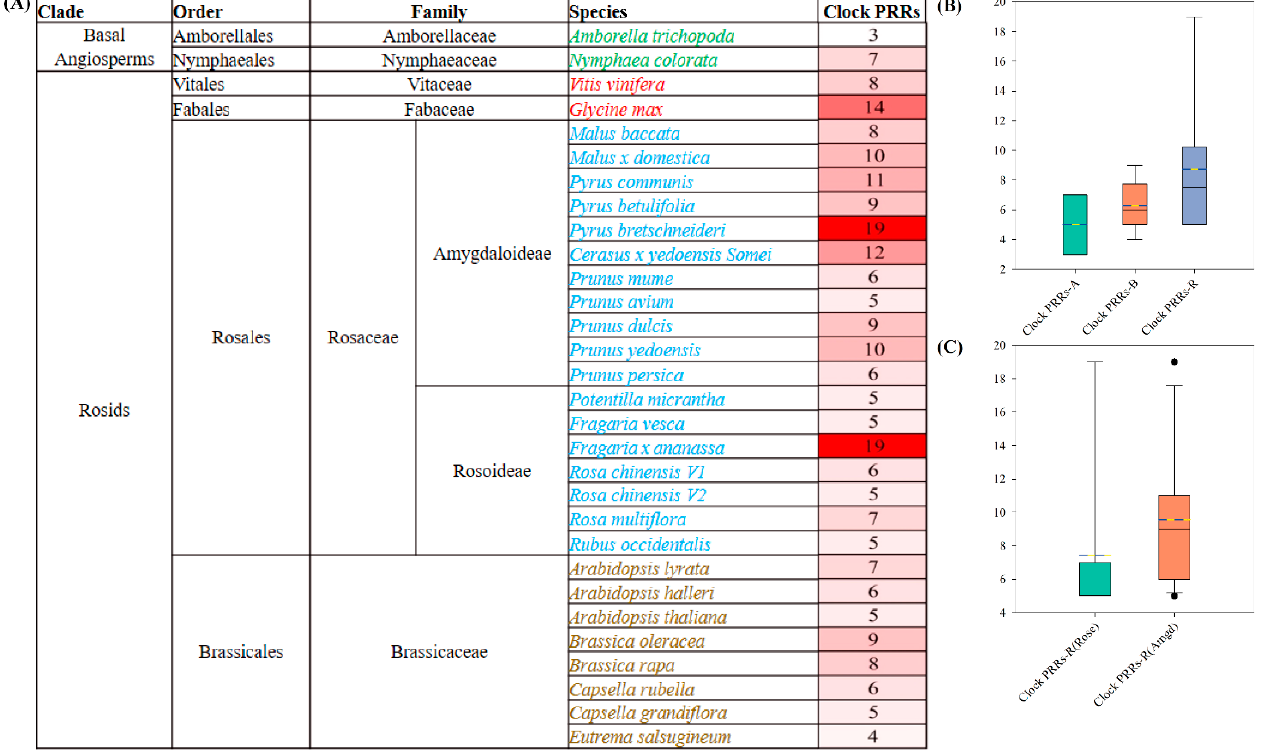
Figure 1. Clock PRRs in basal angiosperms, Brassicaceae and Rosaceae. ( A ) List of the copy number of identified clock PRRs in our study; ( B ) boxplots of the copy numbers of clock PRRs in basal angiosperms, Brassicaceae and Rosaceae. Clock PRRs -A, Clock PRRs -B, and Clock PRRs -R denote the number of clock PRRs in Basal Angiosperms, Brassicaceae, and Rosaceae, respectively; ( C ) boxplots of the copy numbers of clock PRRs in subfamilies of Rosaceae. Clock PRRs -R (Rose) and clock PRRs -R (Amgd) denote subfamily Rosoideae and Amygdaloideae, respectively.